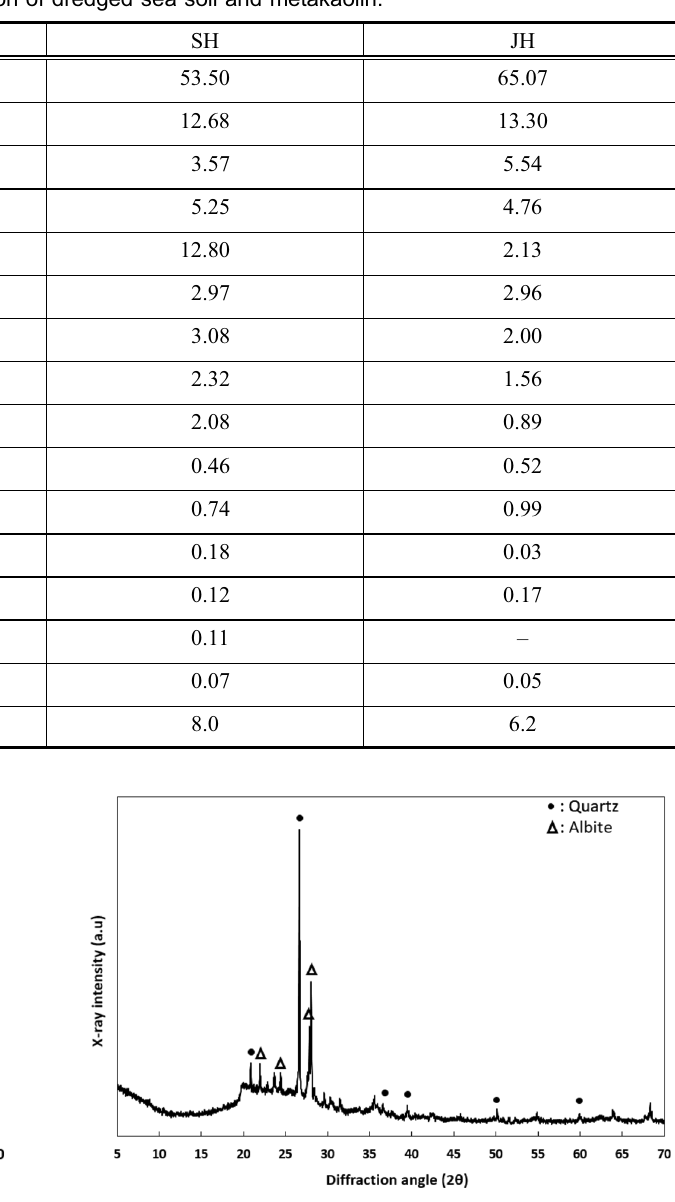
Fig. 1 Particle size distribution of dredged sea soil and metakaolin.